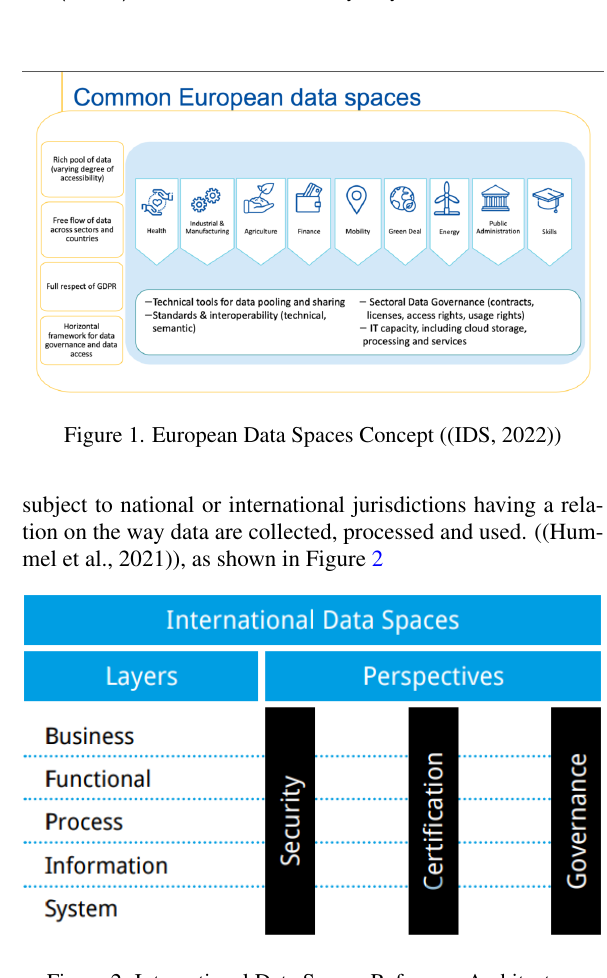
Figure 2. International Data Spaces Reference Architecture Model ((Otto et al., 2019))